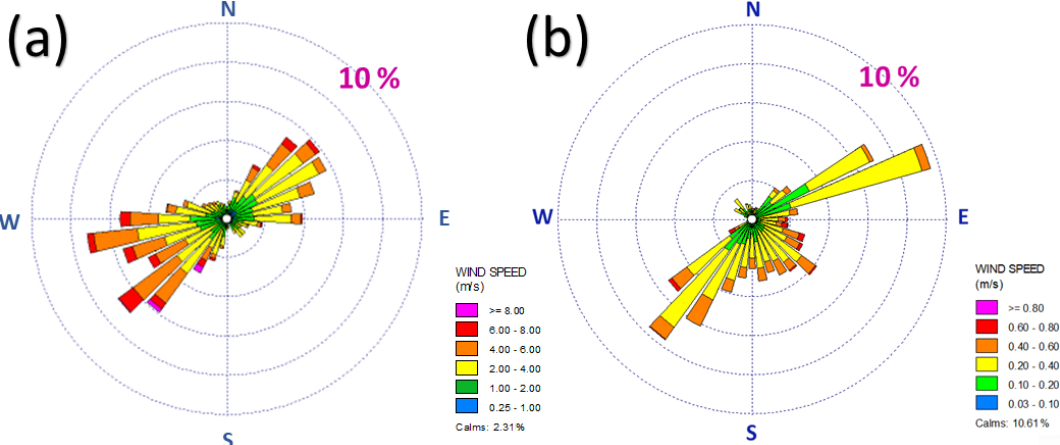
Figure 7. Hourly vector mean wind direction frequencies, in wind rose format, during the experimental period: (a) at 10m and (b) within the Stevenson screen. The outer scale ring represents 10% frequency for both plots, but the scales and class boundaries necessarily differ. Mean wind speed was 2.8ms − 1 at 10m and 0.20ms − 1 within the screen.